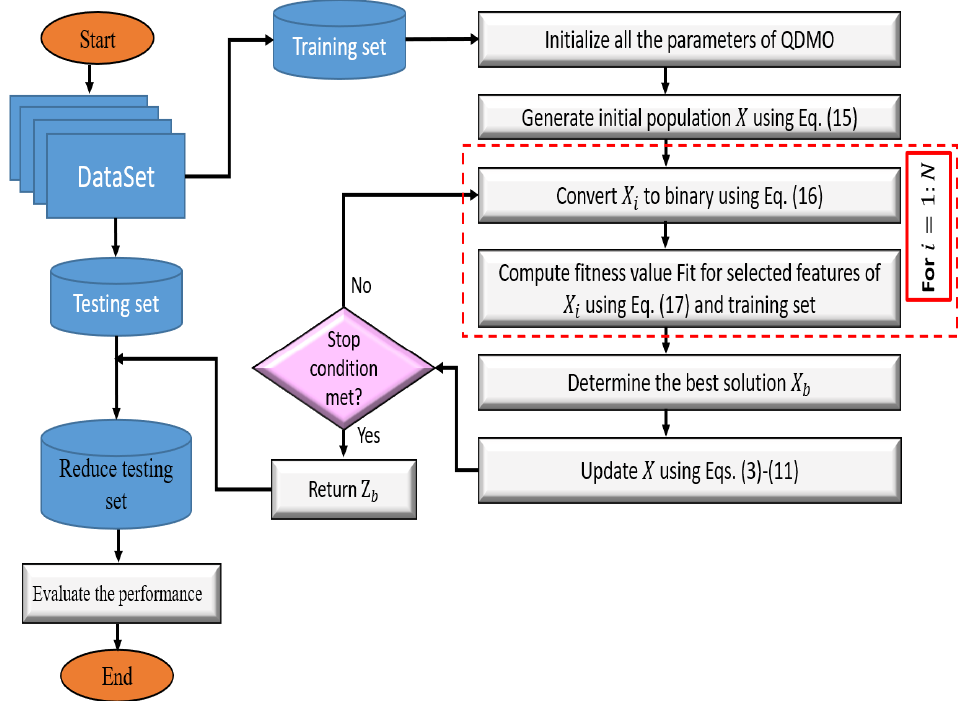
Figure 1. The main work flow of the proposed DMOAQ feature selection